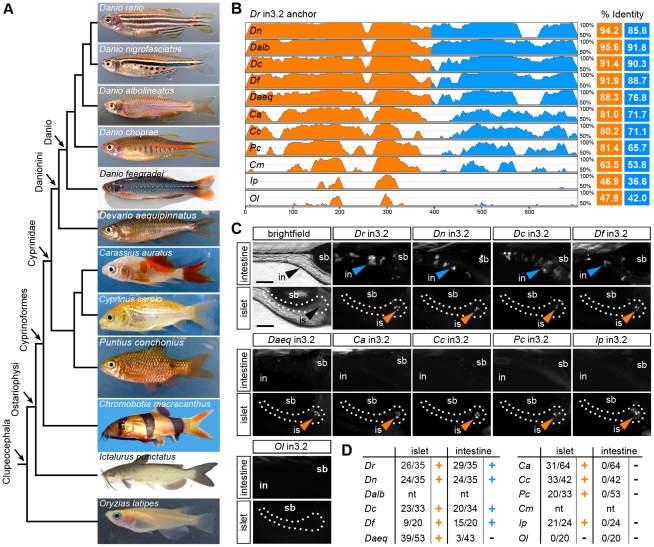
Functional evolution of the islet and intestinal regulatory modules in 12 fish species.(A) Unscaled phylogram based on information from [58], [59] showing images and relative relationships of 12 fish for which intronic sequences were analyzed. Danio rerio (Dr, zebrafish), Danio nigrofasciatus (Dn), Danio albolineatus (Dalb), Danio choprae (Dc), Danio feegradei (Df), Devario aequipinnatus (Daeq, giant danio), Carassius auratus (Ca, goldfish), Cyprinus carpio (Cc, carp), Puntius conchonius (Pc, rosy barb), Chromobotia macracanthus (Cm, clown loach), Ictalurus punctatus (Ip, channel catfish), Oryzias latipes (Ol, medaka). (B) VISTA plot displaying the global pairwise alignment of orthologous in3.2 regions from each species anchored to zebrafish (Dr) in3.2. Orange peaks correspond to regions in the alignment that correspond to Dr in3.3 (islet module). Blue peaks correspond to regions in the alignment that correspond to Dr in3.4 (intestine module). Percent identity is calculated from pairwise alignments of each module with zebrafish (VISTA parameters: 25 bp sliding window, LAGAN alignment). (C) Representative islet and intestinal images from injections of each orthologous in3.2 module. Orange or blue arrowheads mark positive islet or intestine expression, respectively. The absence of arrowheads denotes negative expression in each tissue. (D) Summary of mosaic expression for each species. Ratios of islet or intestine positive fish versus total fish expressing gfp are shown. Orange or blue (+) denotes that the construct was sufficient to confer expression in the islet or intestine, respectively. Black (−) denotes insufficiency. Note that Dalb and Cm sequences were not tested (nt) in this heterologous functional assay. See also Figures S5 and S6.